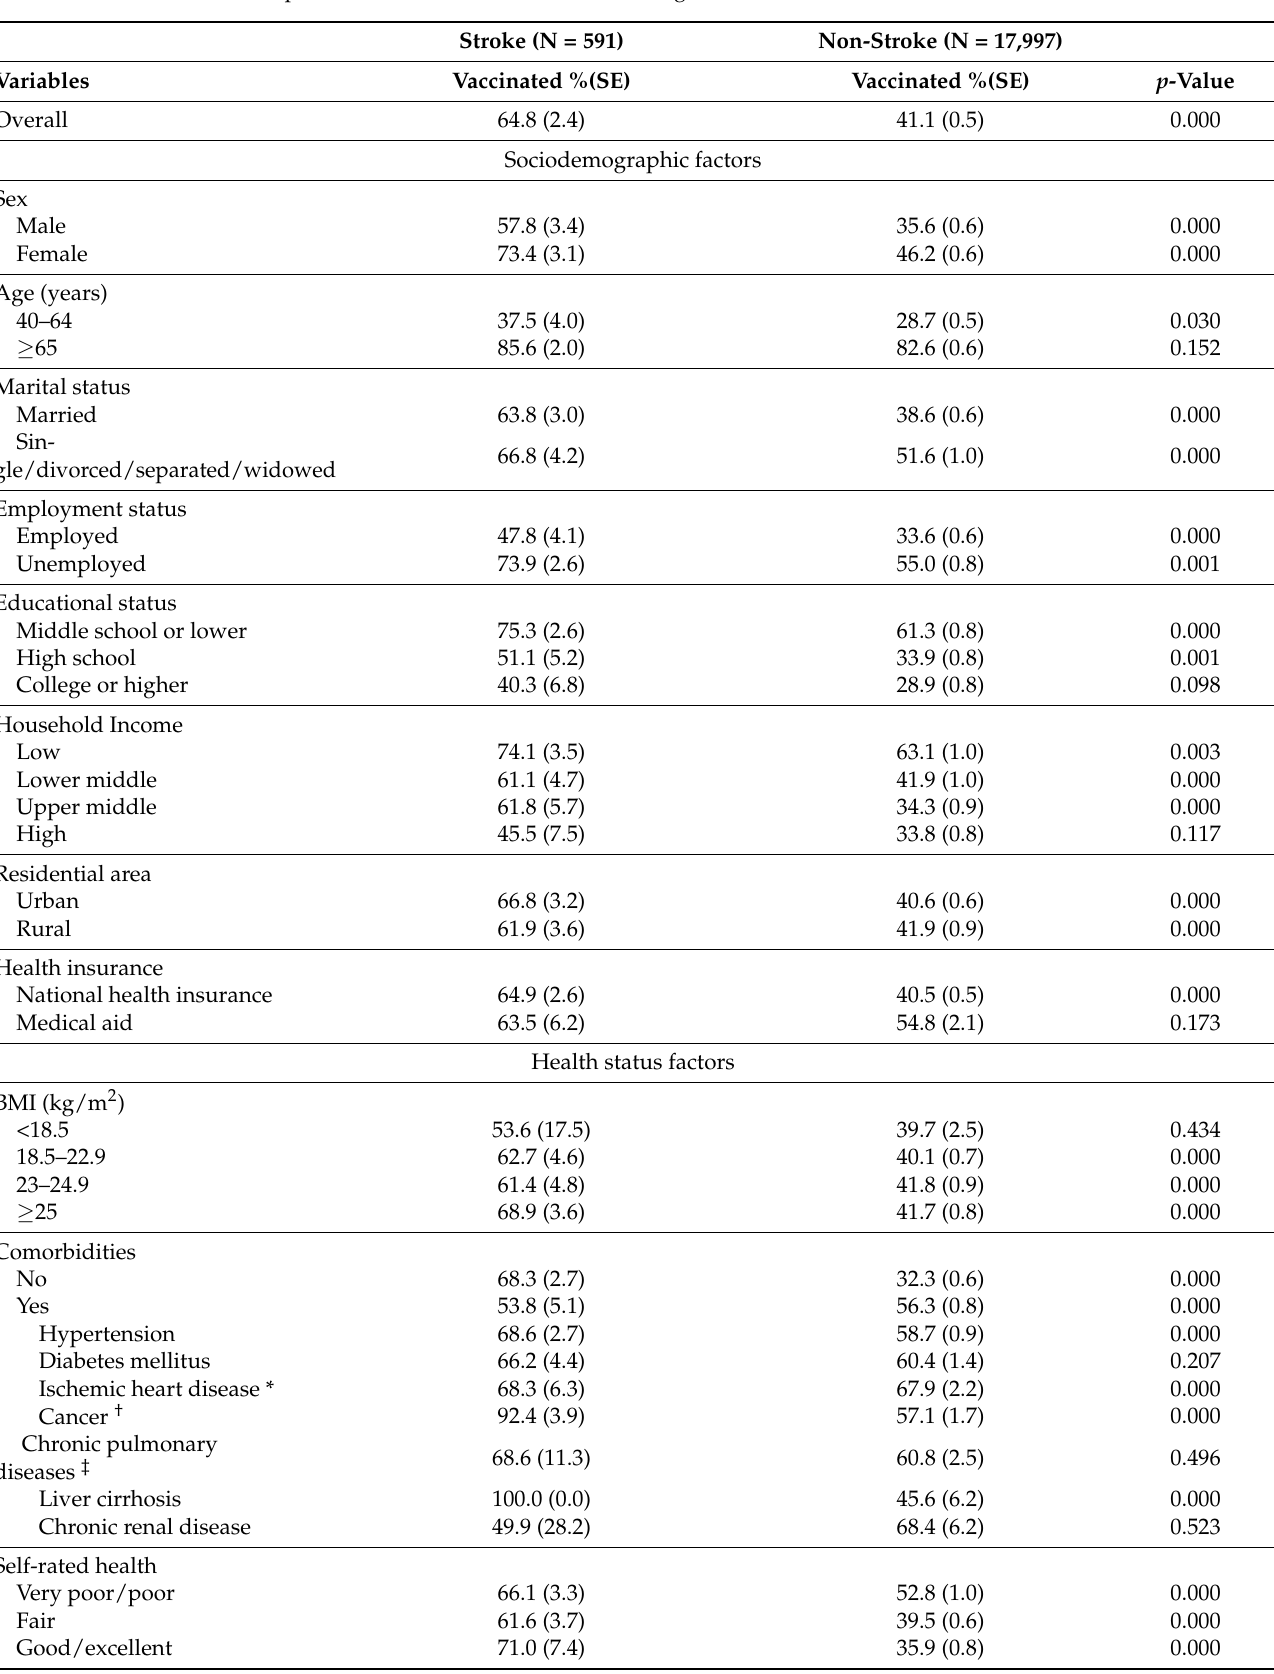
Table 2. Comparison of influenza vaccination coverage between stroke and non-stroke